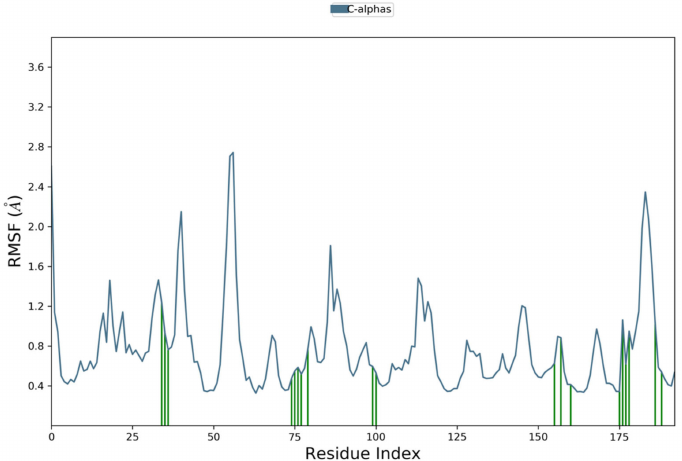
Figure 10. Root Mean Square Fluctuation plot of Comp3 and NS2B-NS3 complex of